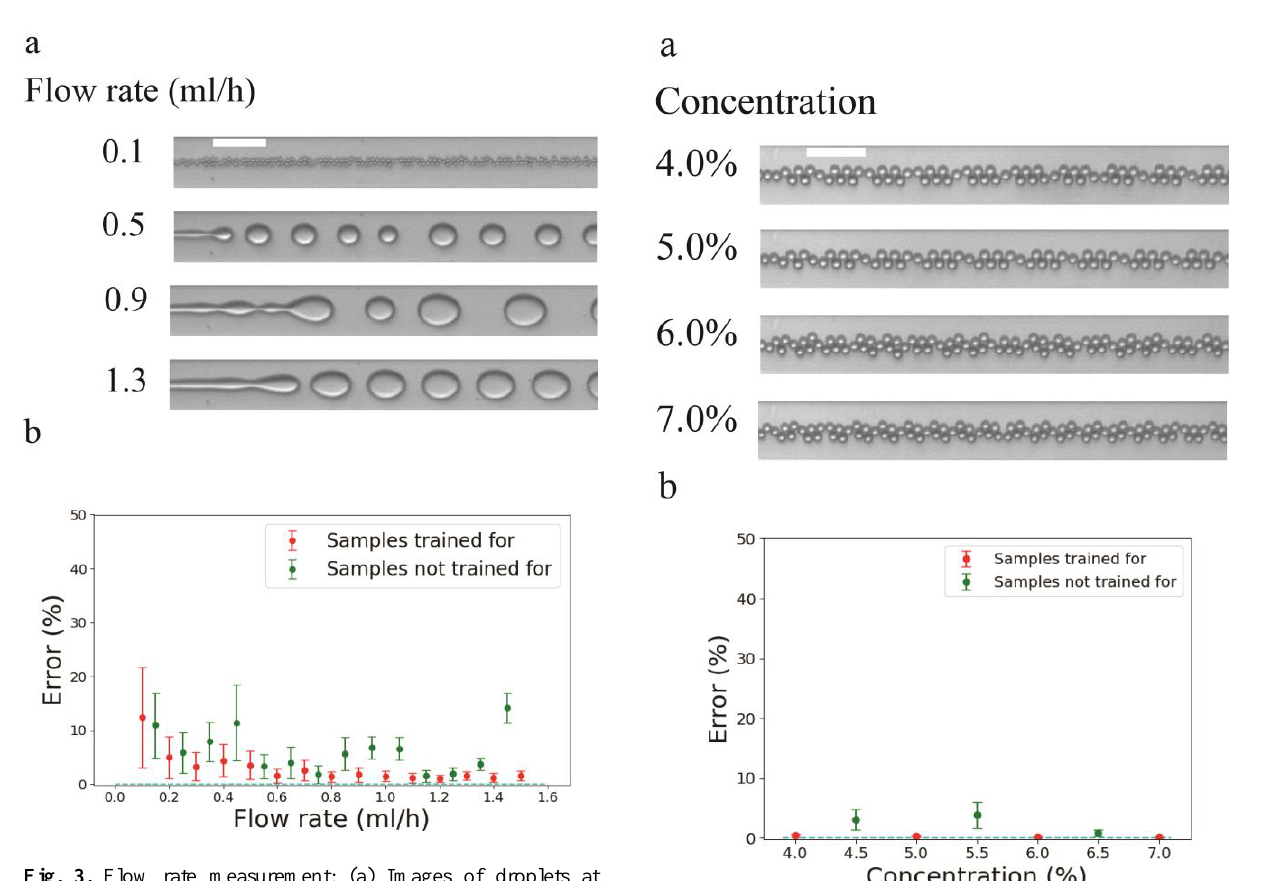
Fig. 3. Flow rate measurement: (a) Images of droplets at different flow rates. (b) Error of measured values by the network at different flow rates. Fig. 4. Concentration measurement: (a) Images of droplets at different concentrations. (b) Error of measured values by the network at different